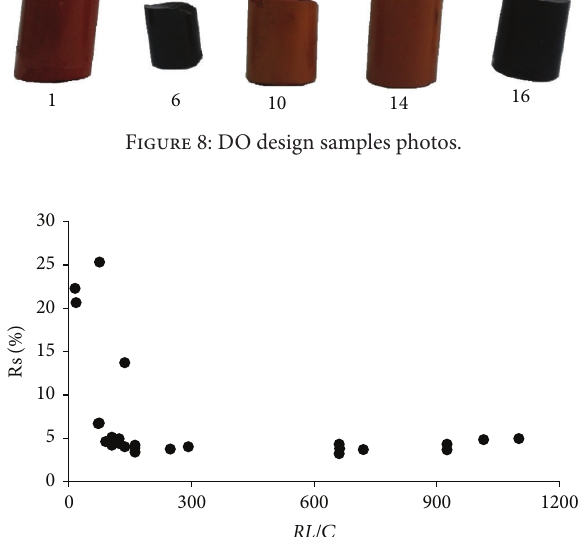
Figure 10: Xerogels porosity in function of their composition.